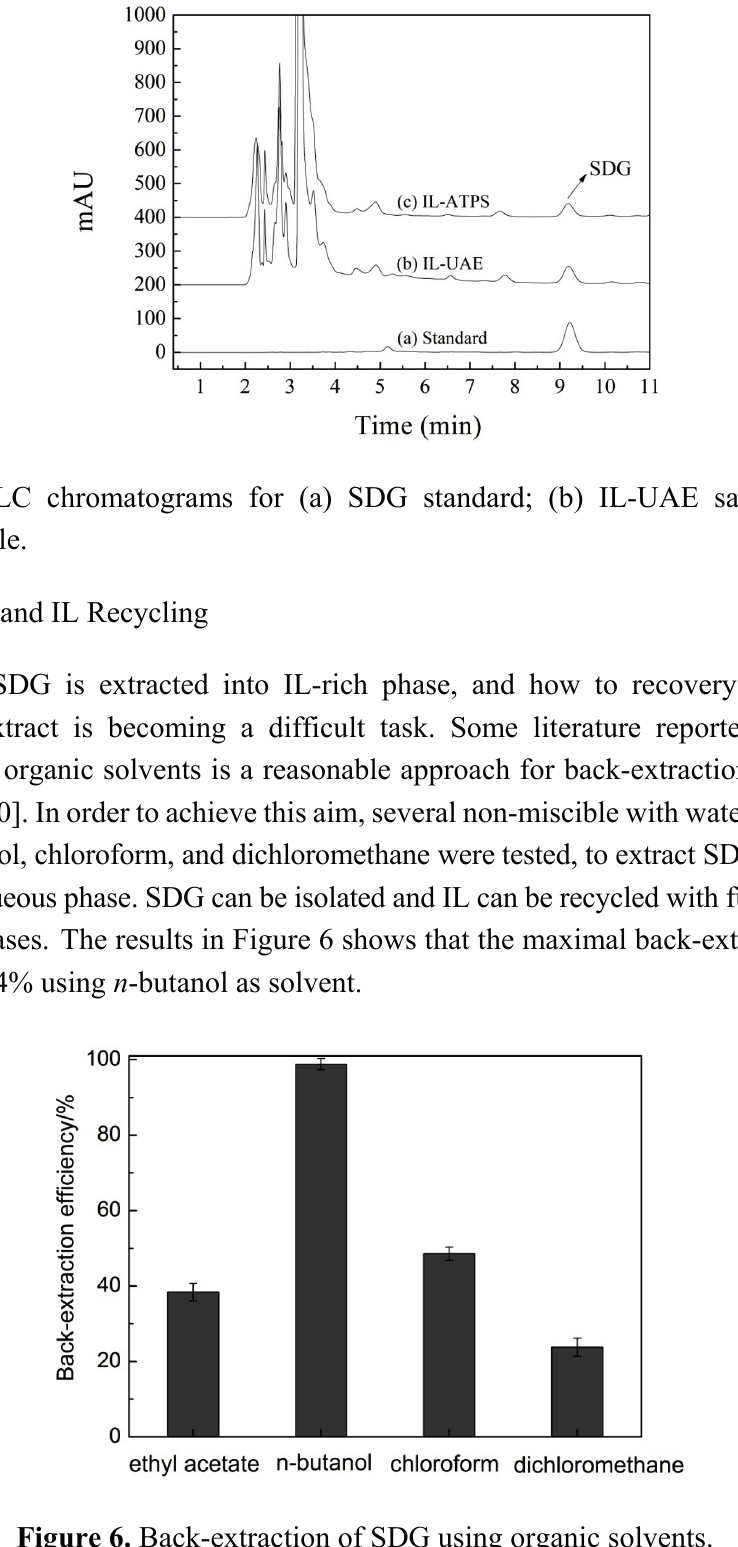
Figure 6. Back-extraction of SDG using organic